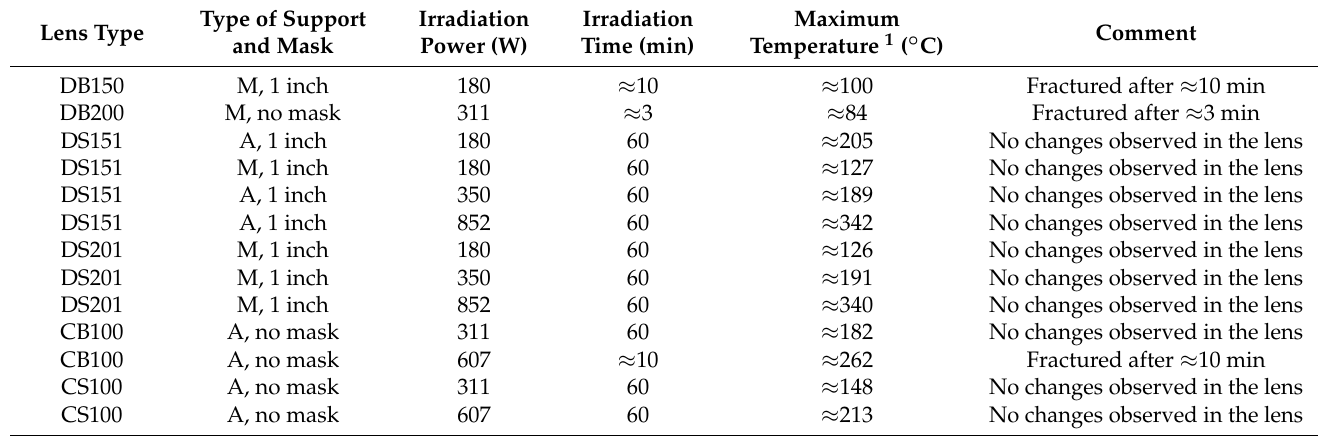
Table 4. Summary of irradiation tests performed with xenon arc